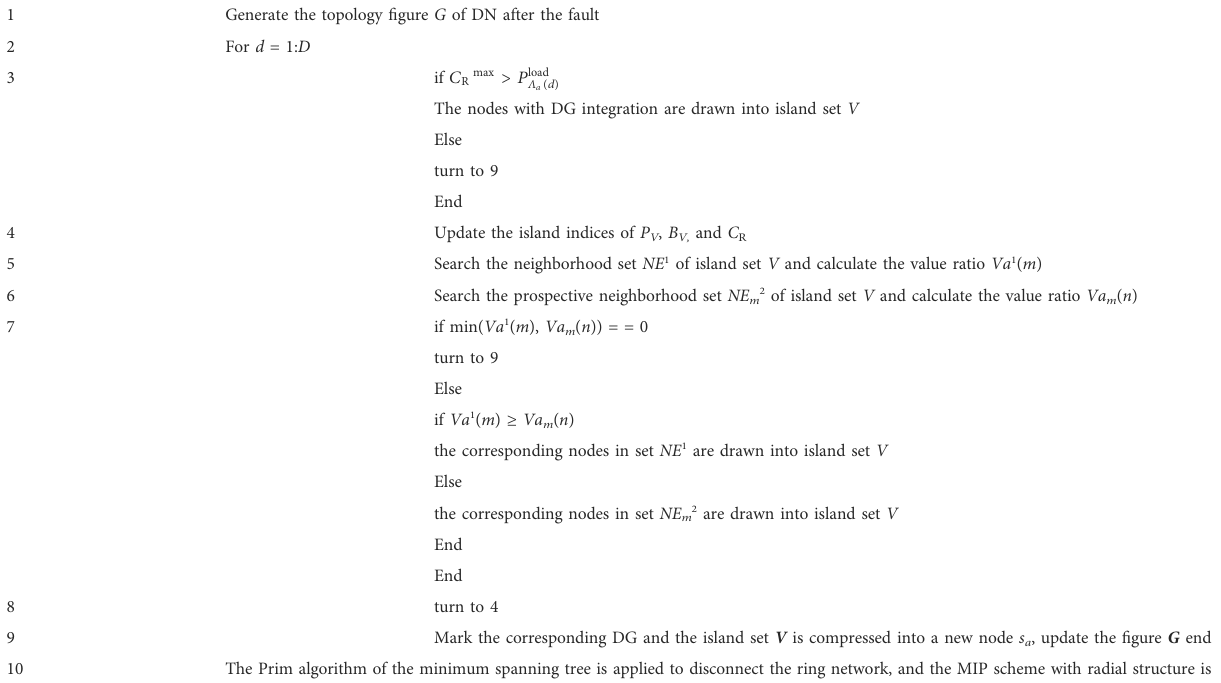
TABLE 1 The prospective greedy algorithm pseudo-code.